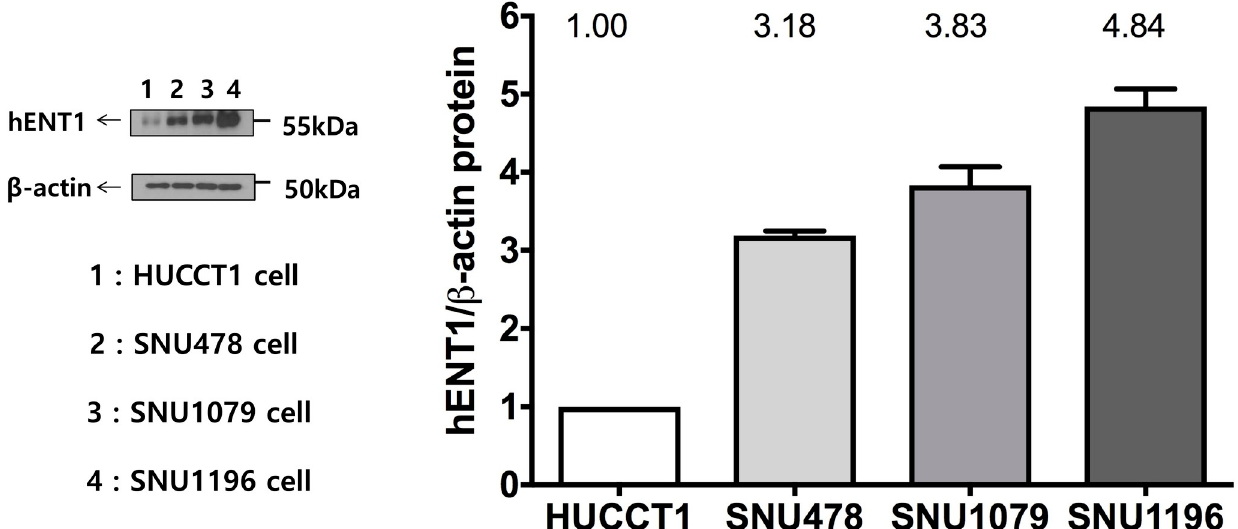
Fig 2. Expression of the hENT1 protein. Baseline levels of protein expression of hENT1 were measured relative to those of HuCCT1 cells by western blotting. SNU1196 showed the highest protein level of hENT1.